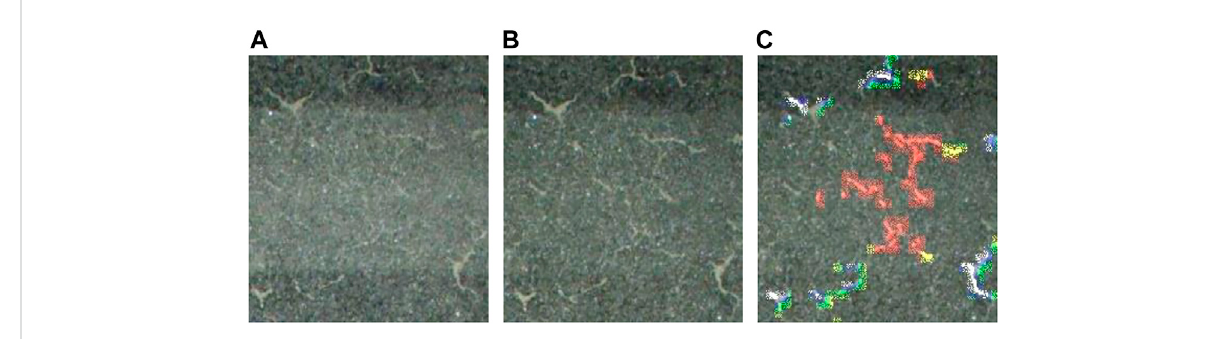
FIGURE 16 The detail of free lime progression results. (A) Surface in 2015. (B) Surface in 2016. (C) Progression results of free